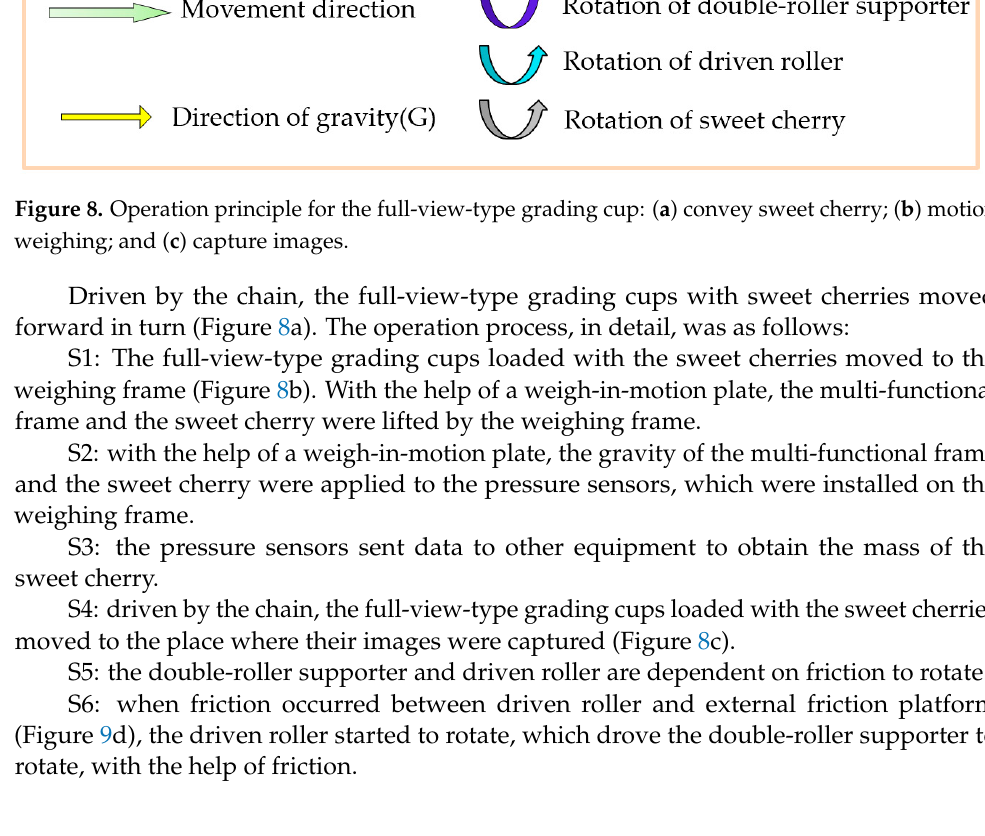
Figure 8. Operation principle for the full-view-type grading cup: ( a ) convey sweet cherry; ( b ) motion weighing; and ( c ) capture images.